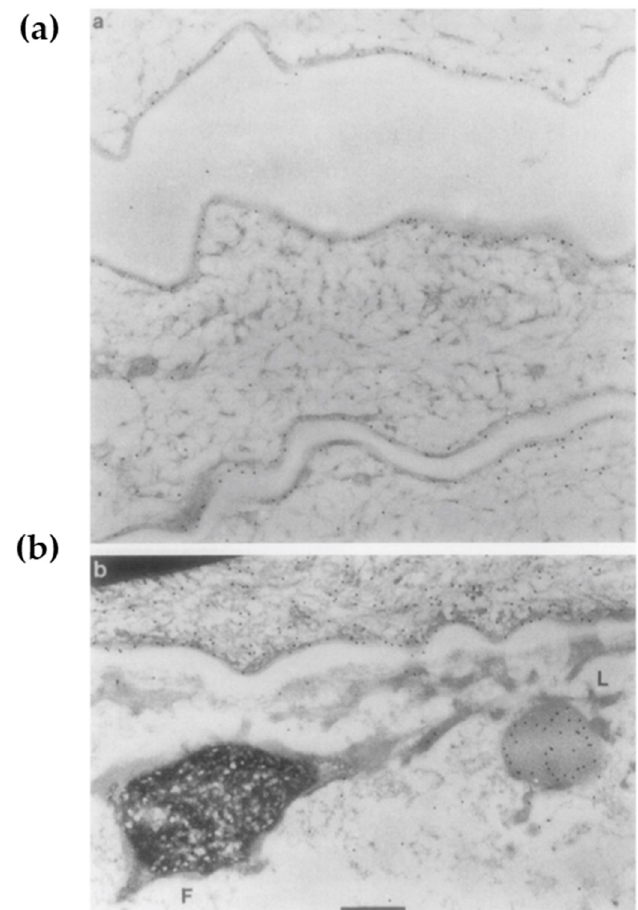
Figure 4. The F-granule and L-granule: “la raison d’être” of the epidermis (adapted from Ref. [30]). Immunoelectron microscopic observation of newborn mouse epidermis labeled with anti-loricrin antibody and protein A-gold (15 nm). In the stratum granulosum (SG), filaggrin-containing F-granules and loricrin-containing L-granules are visible. ( a ) Labeling is predominantly confined to the cell envelope (the cell periphery) at the outer stratum corneum. ( b ) Strong labeling of an L-granule in the SG. In the innermost corneocyte, there is labeling of envelope and cytoplasm. Bar = 0.5 µm.